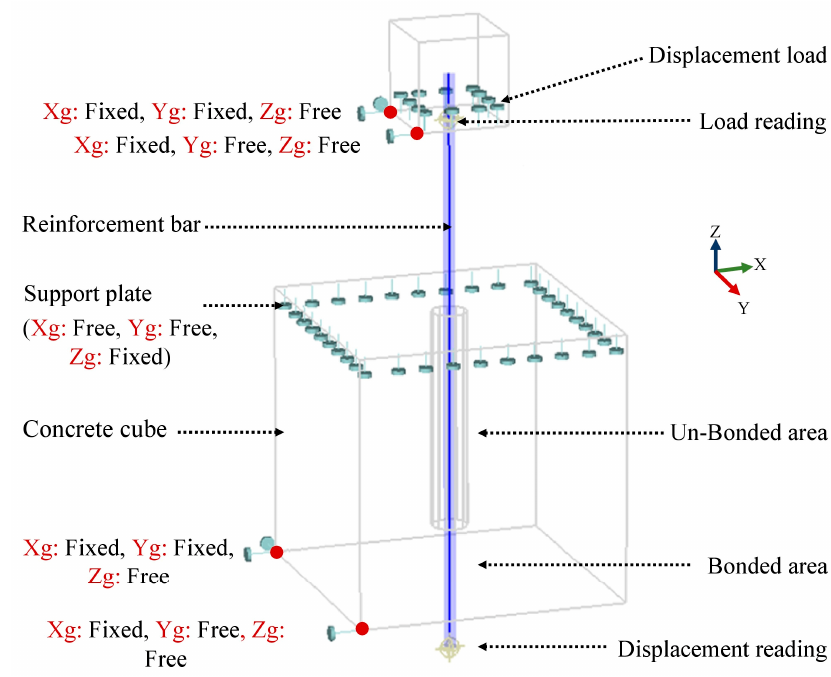
Figure 4. FE model of the pull ‐ out test.